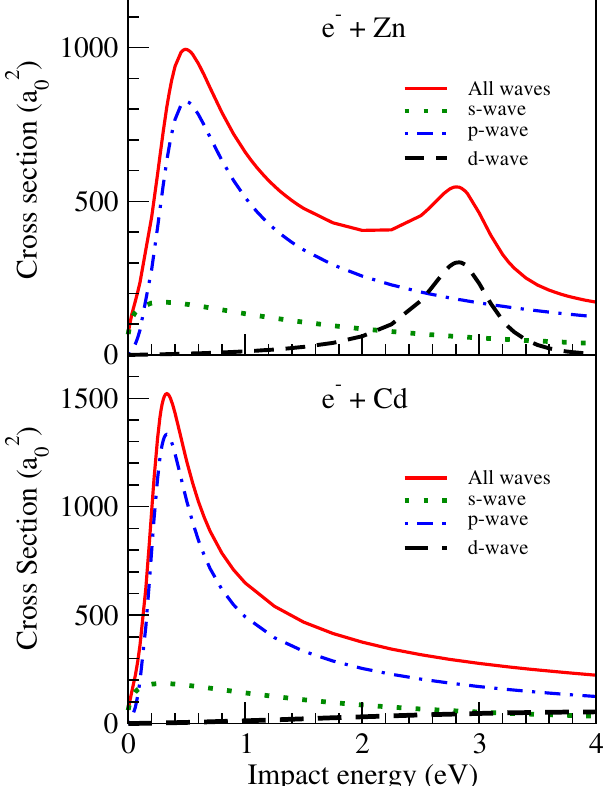
Figure 5. Partial wave contributions to the elastic cross section for electron–Zn ( upper panel) and electron–Cd ( bottom